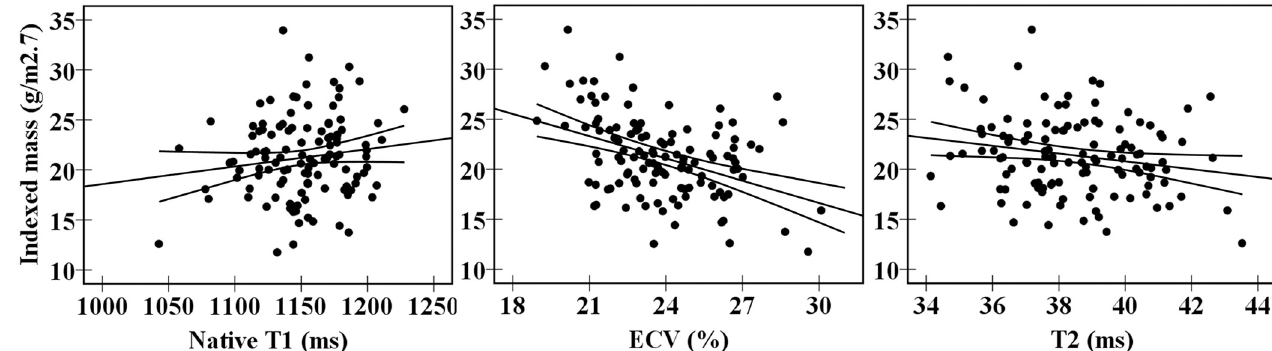
Fig 3. Correlation between myocardial tissue characteristics and left ventricular mass indexed for height to the power of 2.7. From left to right, native T 1 mapping (r = 0.152, P = 0.093), extracellular volume (ECV) (r = –0.413, P < 0.001) and T 2 mapping (r = –0.168, P = 0.063).